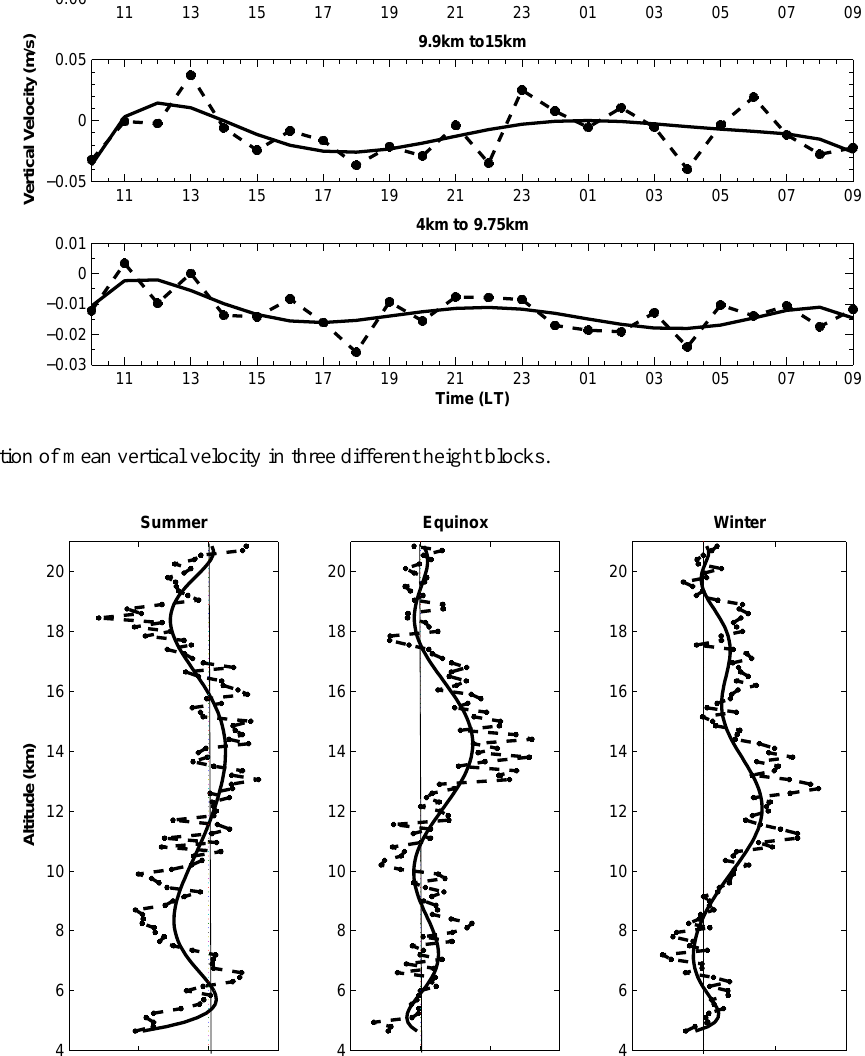
between − 3 to +1 cms − 1 for summer season. Positive val- ues with higher magnitudes ( − 1 to 3 cms − 1 ) are found in the upper troposphere for equinox and winter. Jagannadha Rao et al. (2002) observed large negative velocities ∼ 20 cms − 1 in the lower troposphere during monsoon and also found varia- tion of mean vertical velocity from season to season. The large downward motion was attributed to the presence of gravity waves. Gravity wave activity at this tropical station